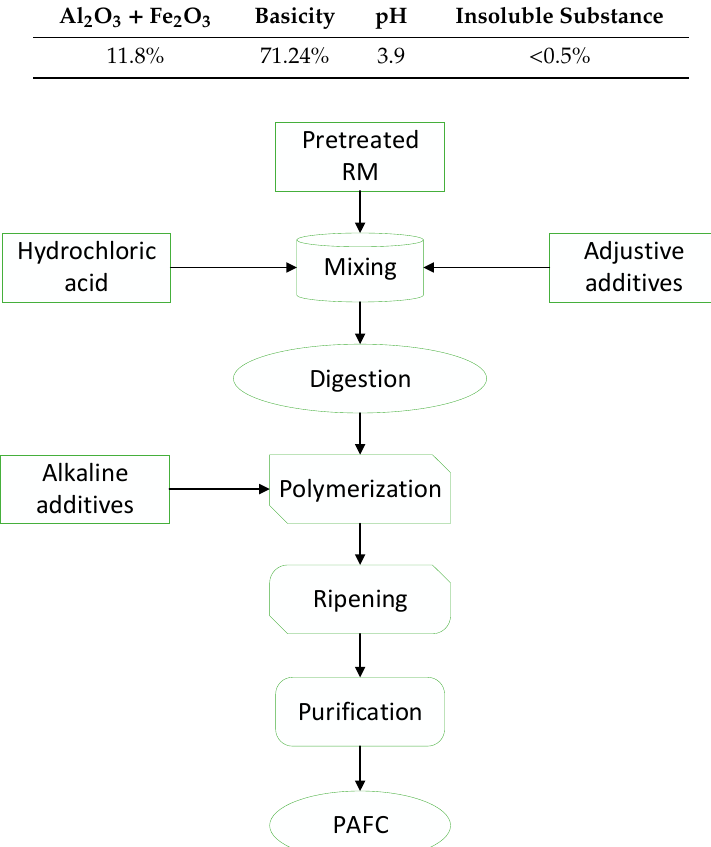
Table 8. Chemical composition of RM polyaluminum ferric chloride (PAFC) [126].